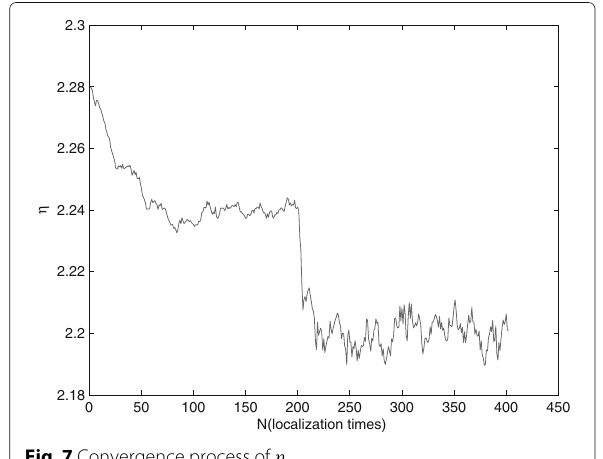
Fig. 7 Convergence process of η